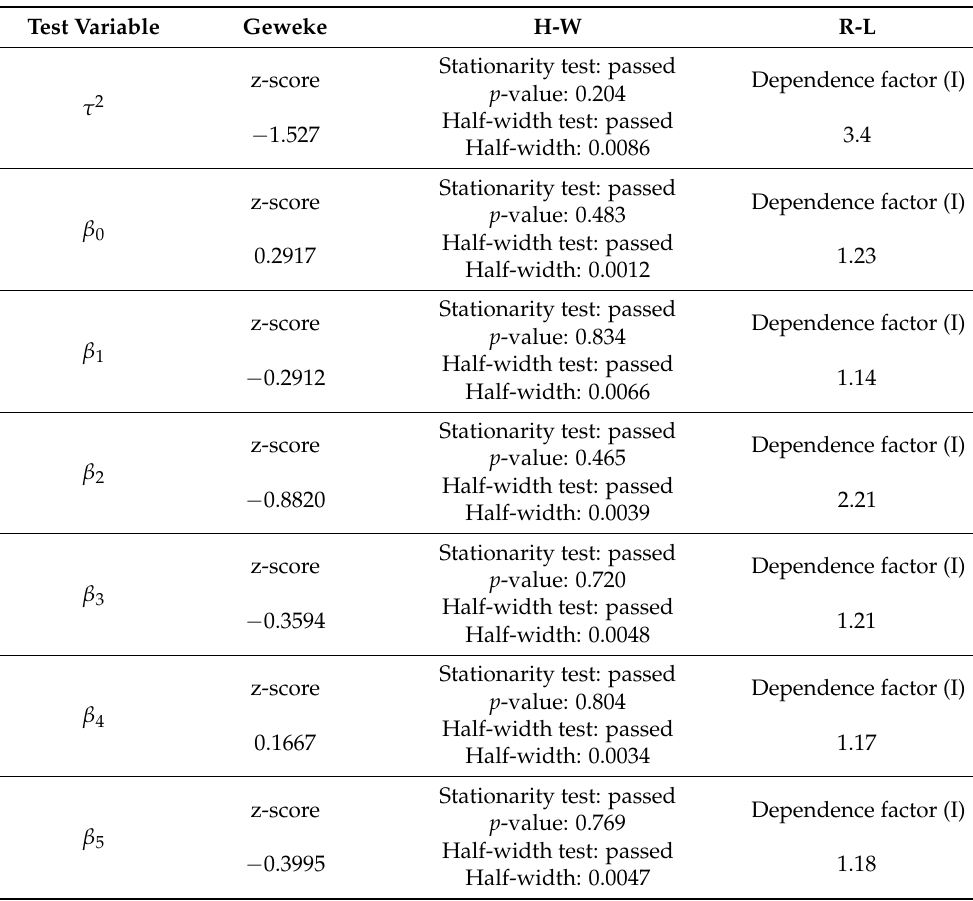
Table 4. MCMC convergence diagnostics for values of τ 2 , β 0 , . . . , β 5 obtained by using the Gibbs sampler algorithm. Tests used included Geweke, H–W, and R–L